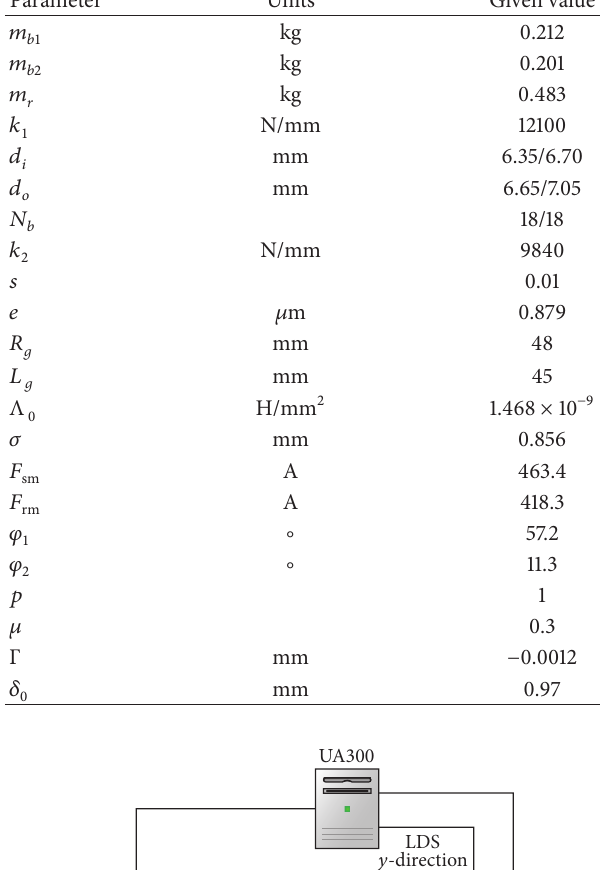
Table 2: First critical speeds of DX100A-24000/20-type motorized